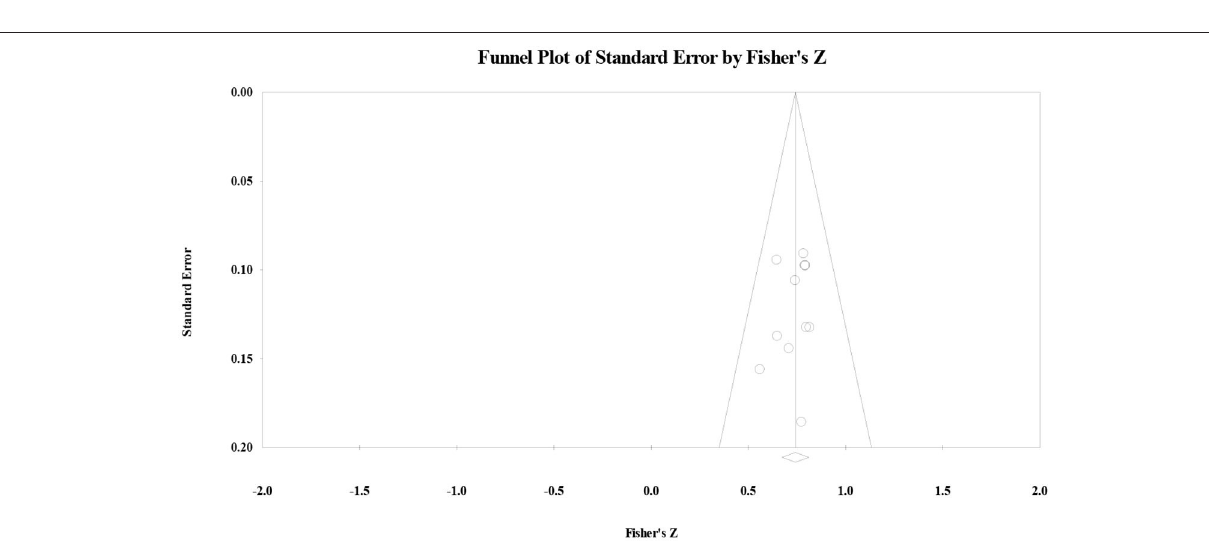
FIGURE 3 | Funnel plot of the correlation effect size between vocabulary knowledge and reading comprehension for secondary school